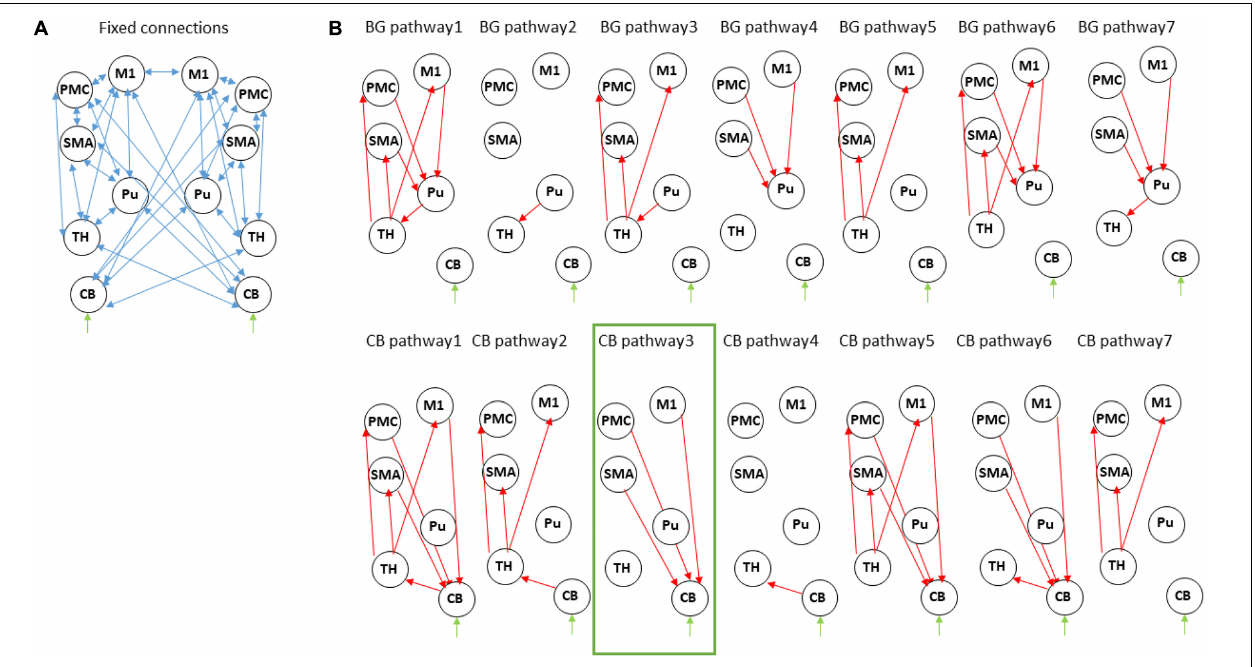
FIGURE 2 | Dynamic causal modeling of the cortico-striatal-thalamo-cerebellar network. (A) Intrinsic connections across all models. (B) Modulatory connections. For simplicity we show only one hemisphere but the modulatory connections are assumed in both. The upper row describes models within the “basal ganglia pathway” with different modulations of the motor-putamen-thalamo-motor circuit. The bottom row describes models within the “cerebellar pathway” with different modulations of the motor-cerebello-thalamo-motor network. M1, primary motor cortex; Pu, putamen; SMA, supplementary motor area; PMC, premotor cortex; TH, thalamus; CB, cerebellum. The winning model is marked in